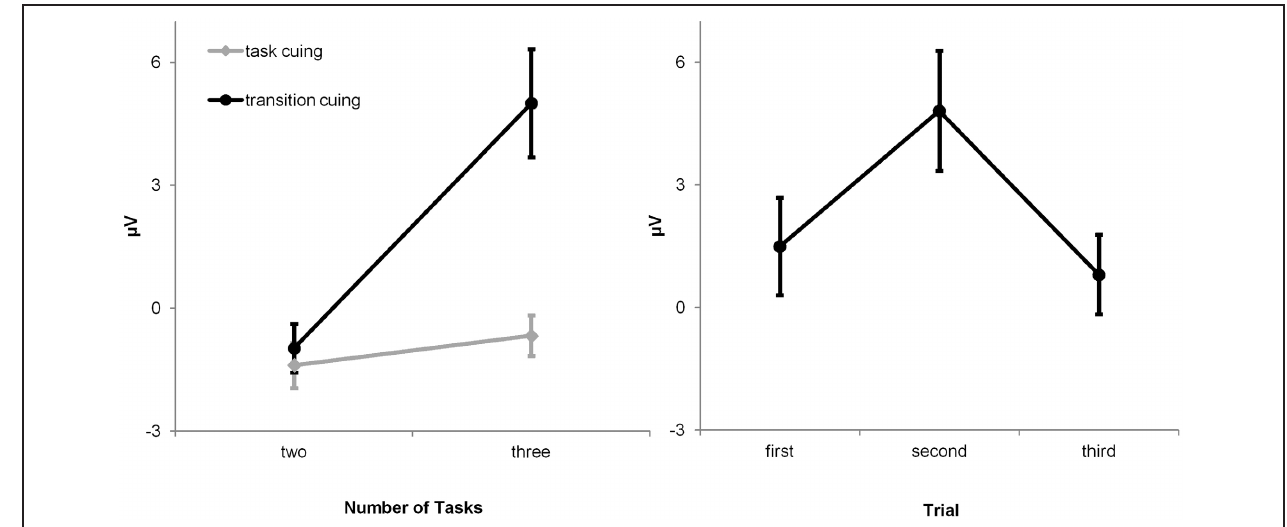
FIGURE 6 | Mean (standard error) P3a amplitudes at Fz. Left panel: The interaction between cue explicitness and number of tasks reveals that P3a amplitudes vary as afunction of post-switch outcome uncertainty which ishigh